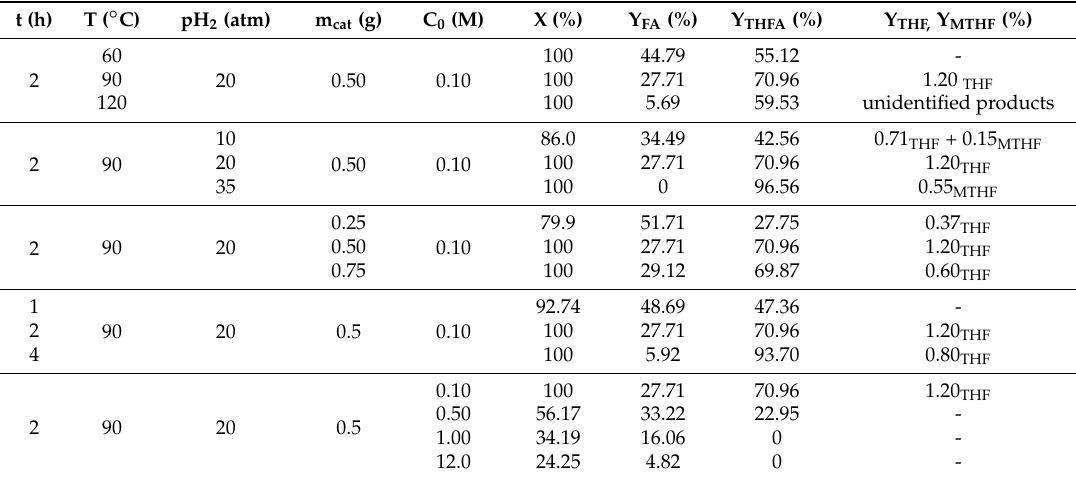
Table 3. Conversion of furfural over Pd/Al 2 O 3 catalysts and yields of FA and (THFA).